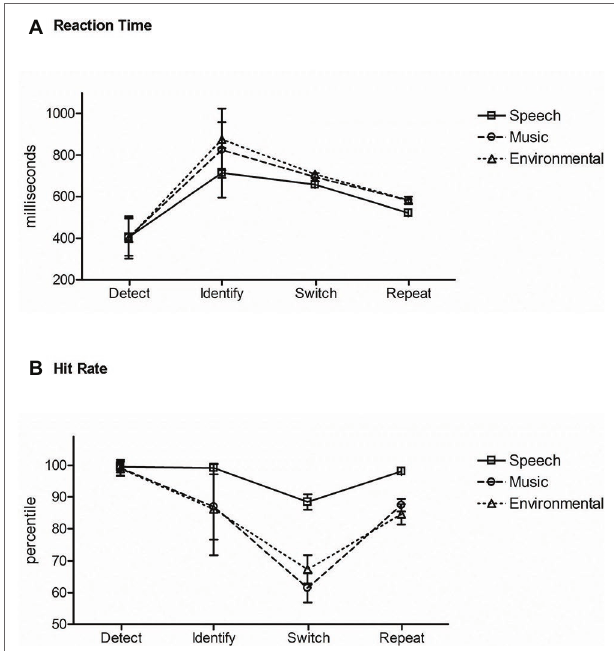
FIGURE 5 | Comparison of task responses across conditions. (A) Reaction time: mean RT is displayed in response to speech (square, solid line), music (circle, dashed line), and environmental (triangle, dotted line) sounds for each task (denoted across the x axis): the Detection condition (Detect), Identification condition (Identify), and the Repetition-Switch condition with Position 1 switch trials (Switch), and Position 5 repeat trials (Repeat). (B) Hit rate: mean HR is displayed for speech (square, solid line), music (circle, dashed line), and environmental (triangle, dotted line) sounds for each task (denoted across the x axis): the Detection condition (Detect), Identification condition (Identify), and the Repetition-Switch condition with Position 1 switch trials (Switch), and Position 5 repeat trials (Repeat). Whiskers show standard